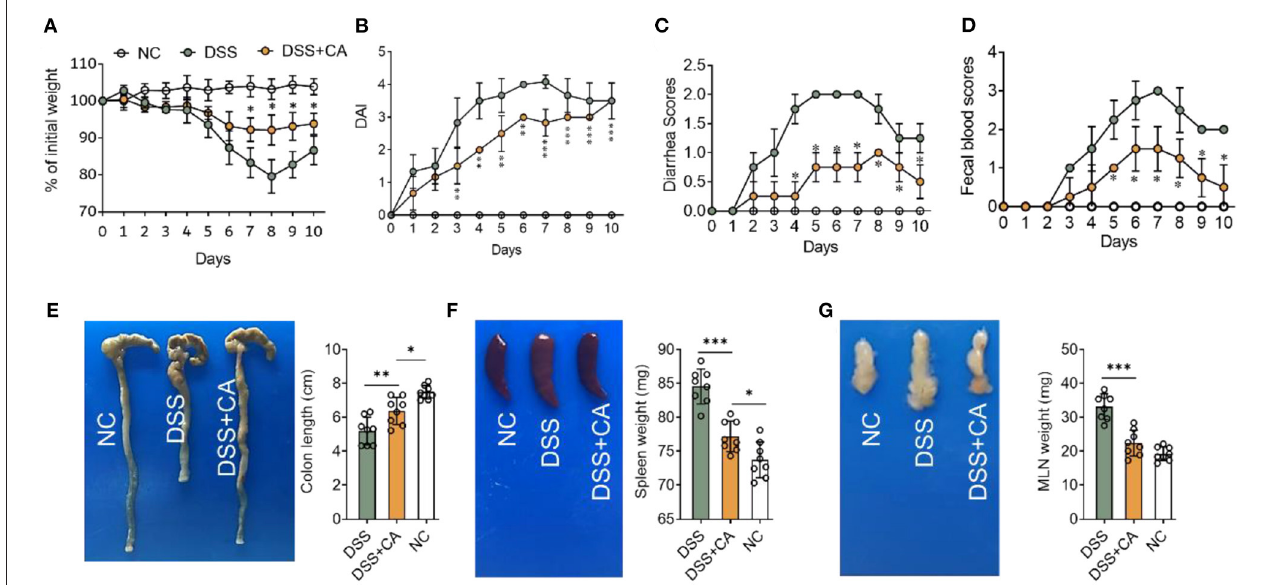
FIGURE 1 | Carnosol (CA) alleviates the clinical signs in mice with DSS-induced colitis. Experimental colitis was induced by DSS (exposure to DSS for 7 days, followed by 3 days of recovery). Mice were fed with DSS (2.5%, w/v) in their drinking water with or without daily intraperitoneally with CA, while naïve control (NC) mice received regular drinking water. (A) Body weight changes following DSS induction of colitis. Data were recorded as a percentage of the initial body weight. (B) The DAI scores were recorded every day. The DAI scores were calculated according to weight loss, diarrhea and rectal bleeding. (C) Diarrhea was scored as follows: normal stool = 0, soft = 1, and watery = 2. (D) Rectal bleeding scores were determined as follows: no bleeding in stool = 0, blood traces in stool visible = 1, gross rectal bleeding = 3. Data are expressed as mean ± SD. (A – D) DSS group: n = 8, DSS + CA group: n = 8, NC group: n = 8. (E) Representative colon photos (left) and quantification of colon length (cm) of 3 groups (right). Colon length comparisons were shown in histogram. Representative gross morphology of spleens ( F , left) and lymph nodes ( G , left). Quantitative analysis of the weight (mg) of spleens ( F , right) and lymph nodes ( G , right). One-way analysis of variance (ANOVA) followed by Tukey’s multiple comparisons test, * p < 0.05, ** p < 0.01, and *** p <